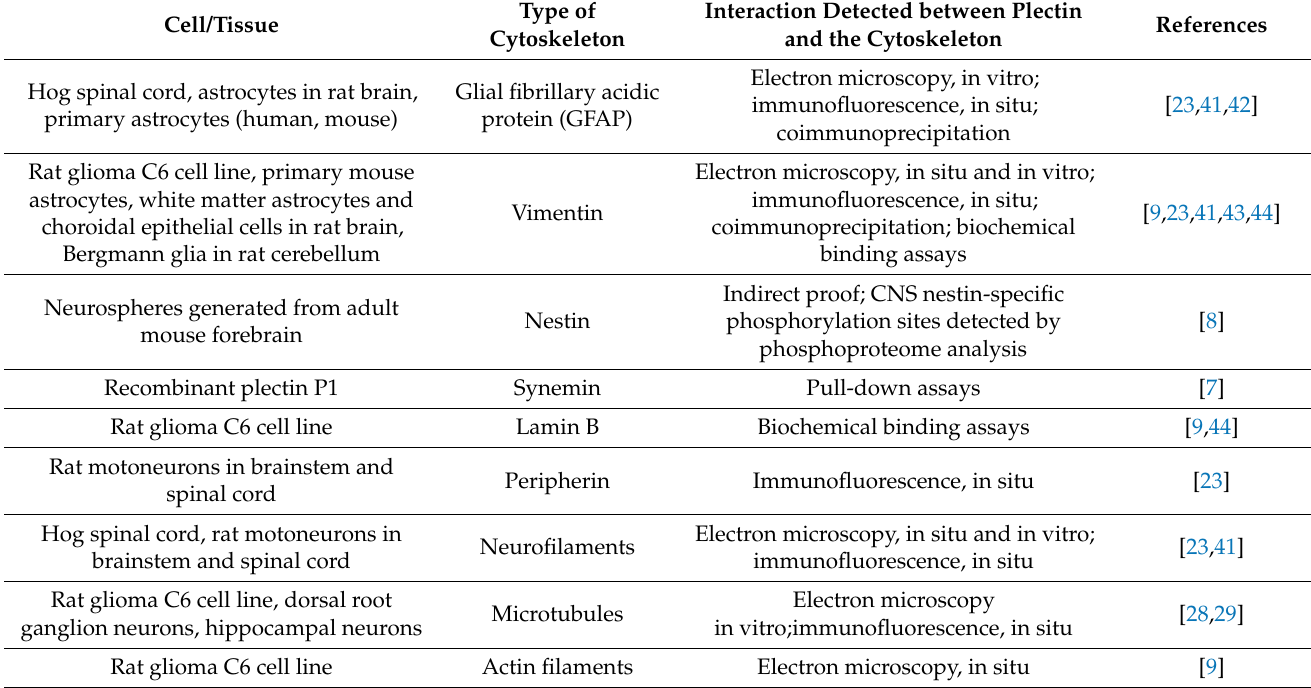
Table 1. Crosslinking and co-localization of plectin with cytoskeleton in cells and tissues of the central nervous system. Type of Interaction Detected between Plectin Cell/Tissue Cytoskeleton and the